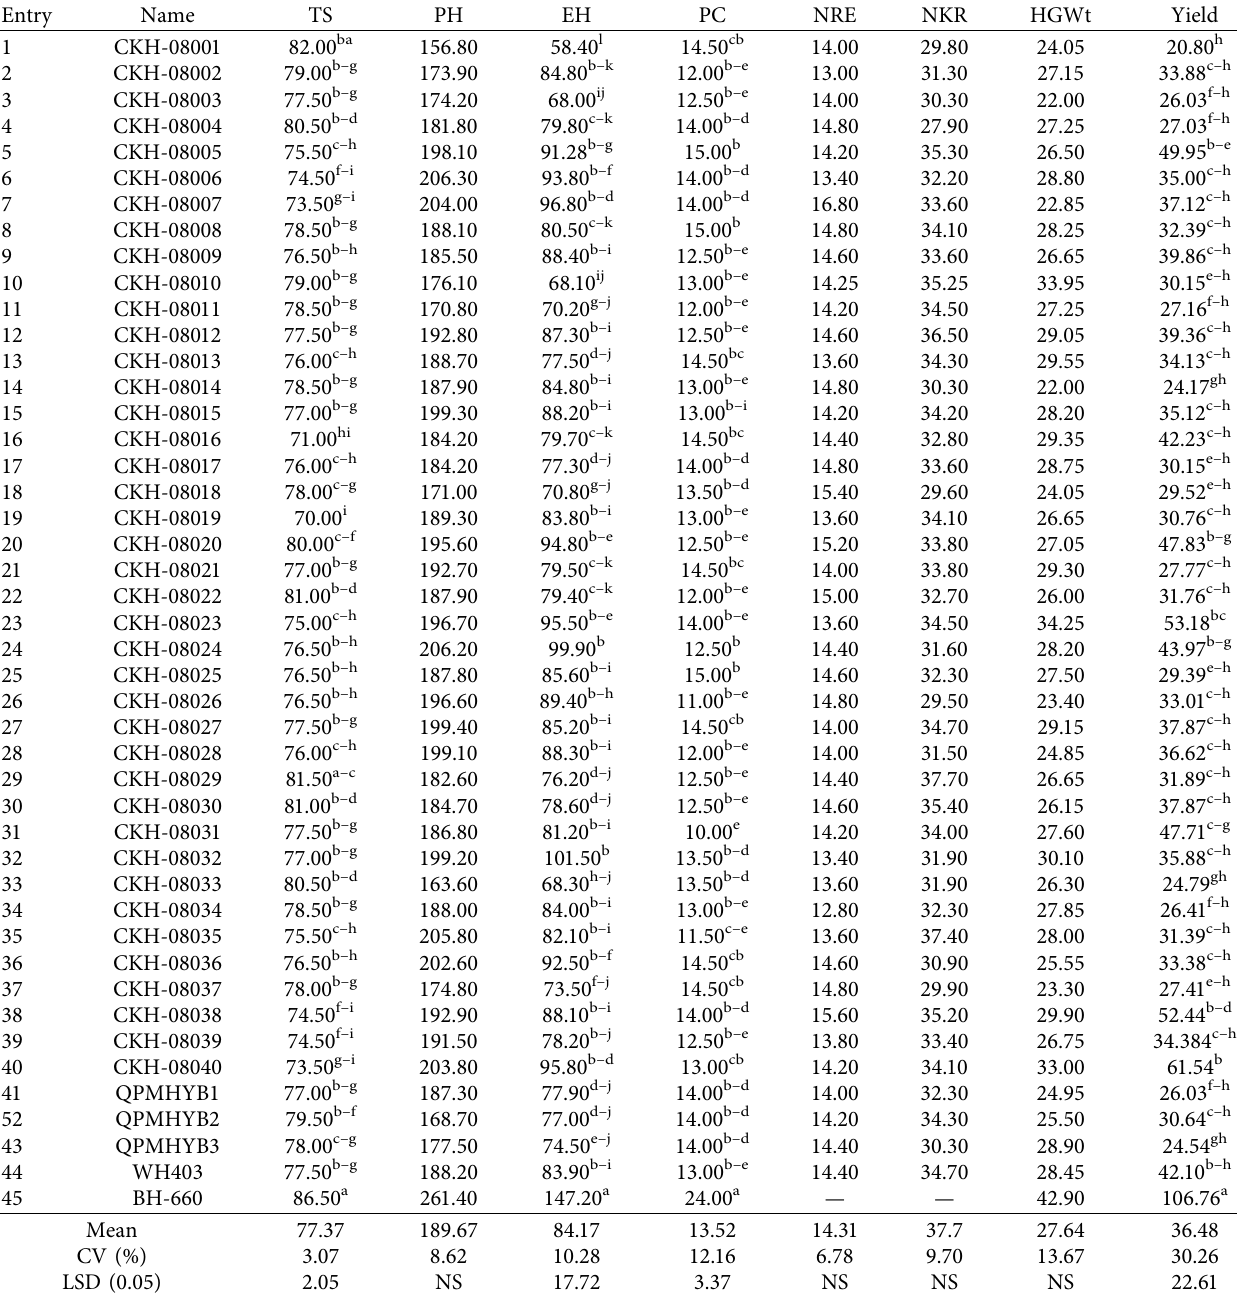
Table 2: Mean performance of QPM hybrids evaluated at the College of Agriculture and Veterinary Medicine (Jimma University, Ethiopia) for different